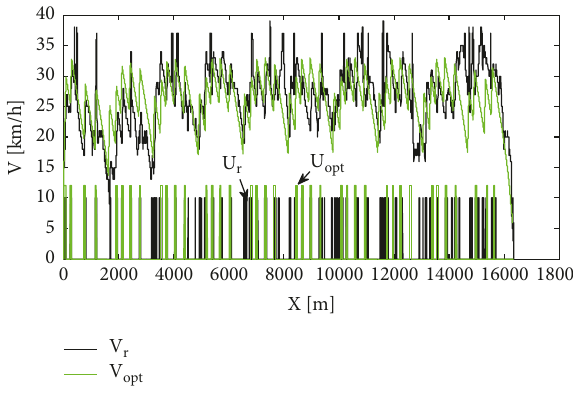
Figure 19: Comparison of speed and control signal during attempt 2.